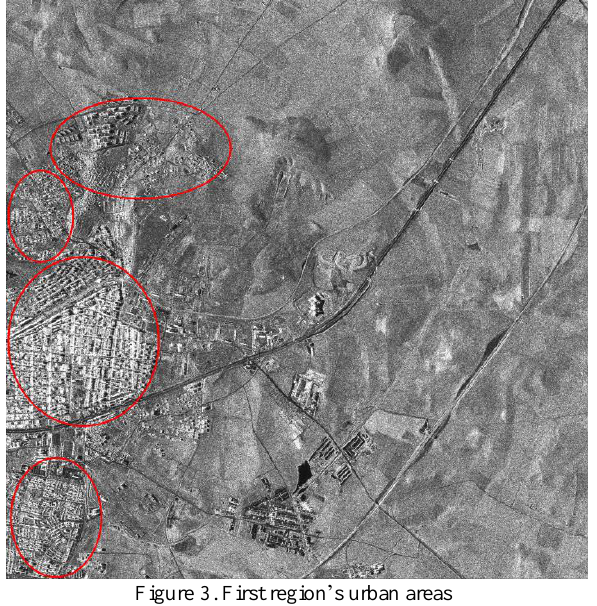
Figure 3. First region’s urban areas